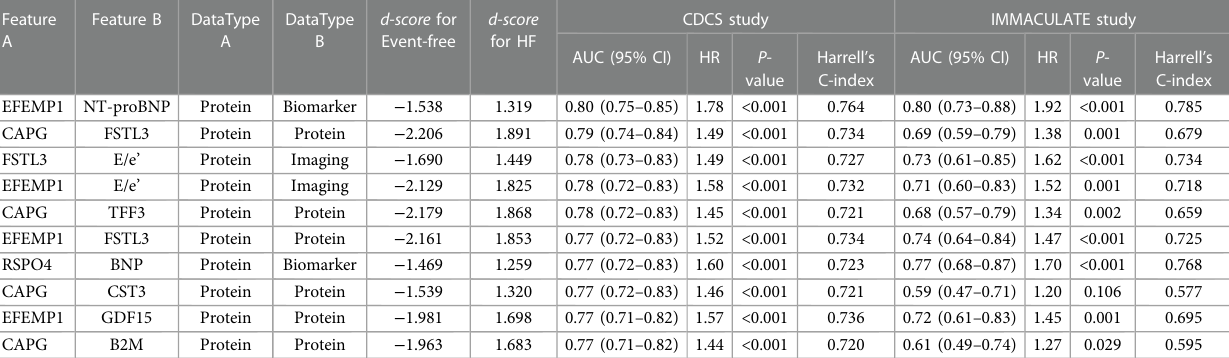
TABLE 4 The predictive performance and hazard ratios of the top ten pairs of data features with the highest AUC and largest magnitude of d-scores for HF in the CDCS and IMMACULATE cohorts.